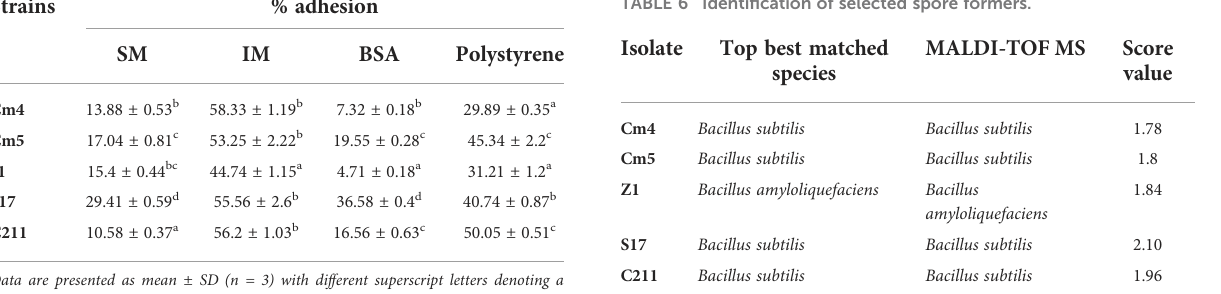
TABLE 6 Identi fi cation of selected spore